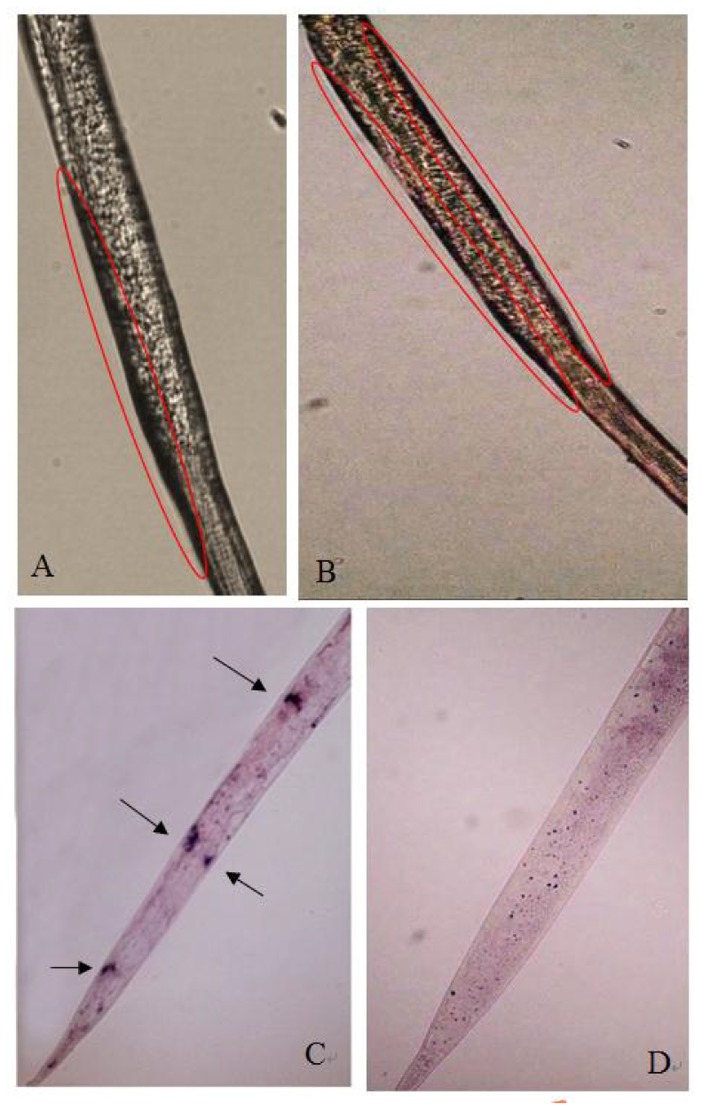

In situ localization of Rs-FAR-1 in Radopholus similis.A, B, C:In situ hybridization with the antisense ssRNA probe-signals were observed in cuticle of R. similis; D: In situ hybridization with the sense ssRNA probe. Red circles and arrows indicate the In situ hybridization signals; panels A, B and D show females and panel C shows larvae.